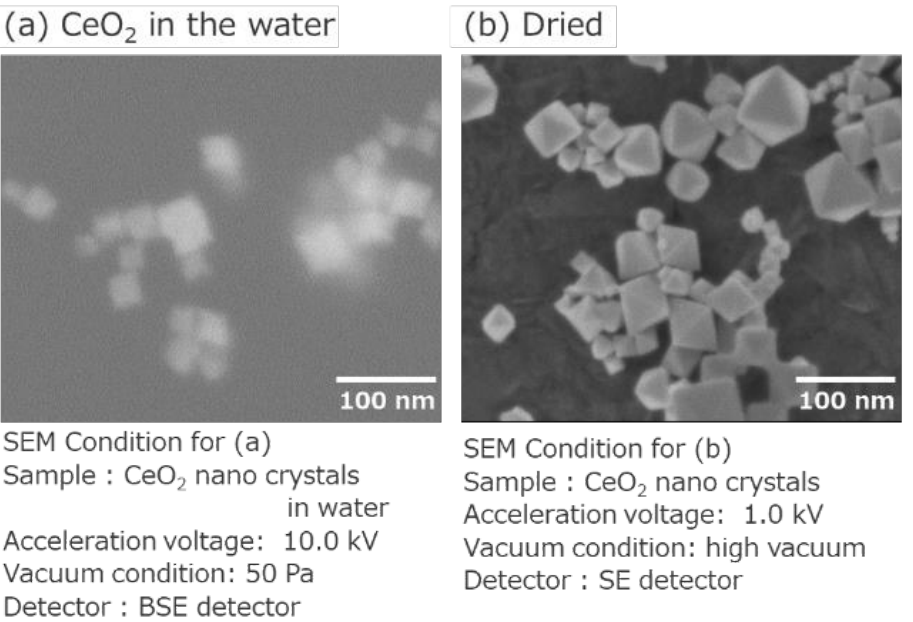
Figure 8. BSE image of in situ observation for CeO 2 in water. ( a ) An image of the CeO 2 nanocrystals in water. ( b ) An image of the dried CeO 2 nanocrystals.